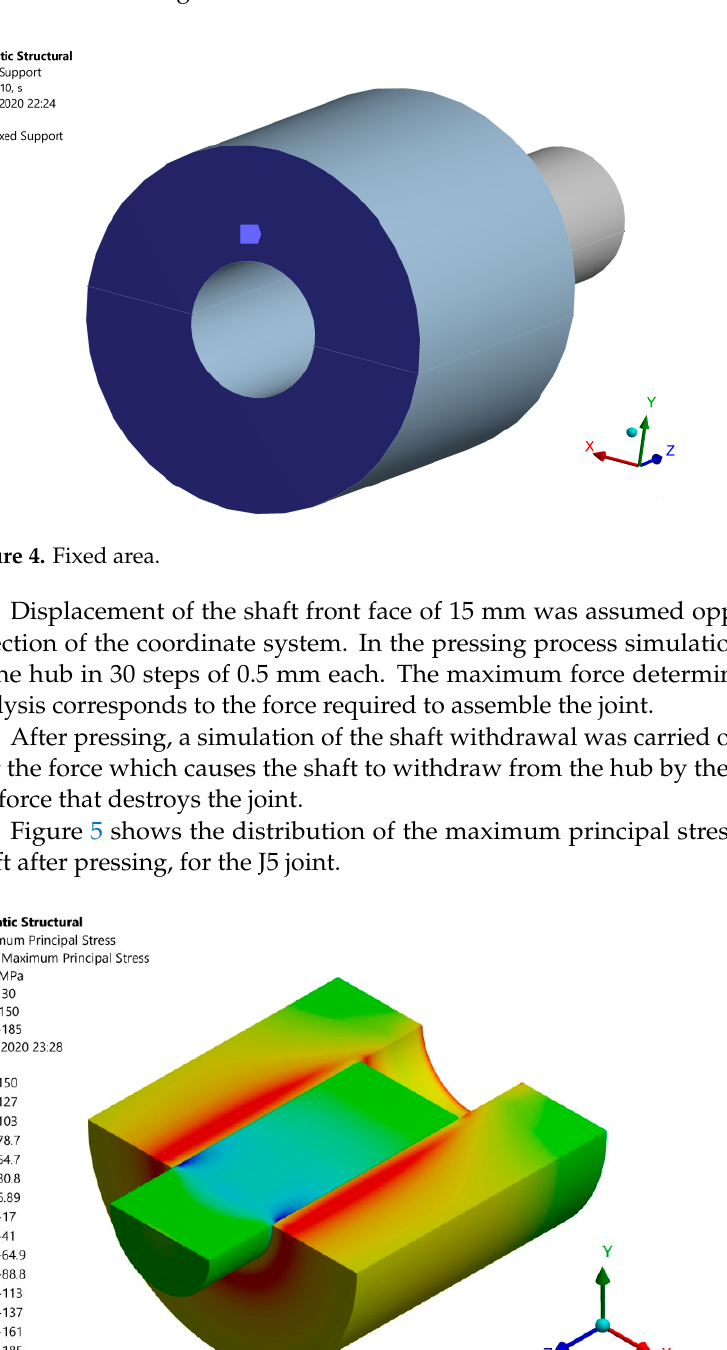
Figure 3. A discrete model.